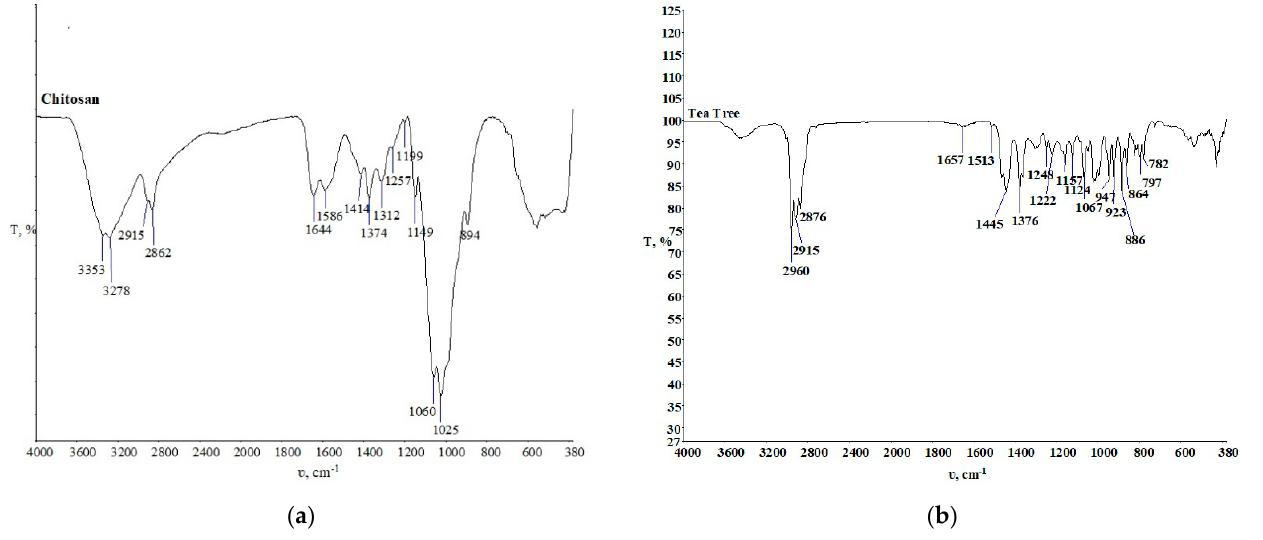
Figure 7. FTIR spectra of chitosan ( a ) and tea tree essential oil ( b ).